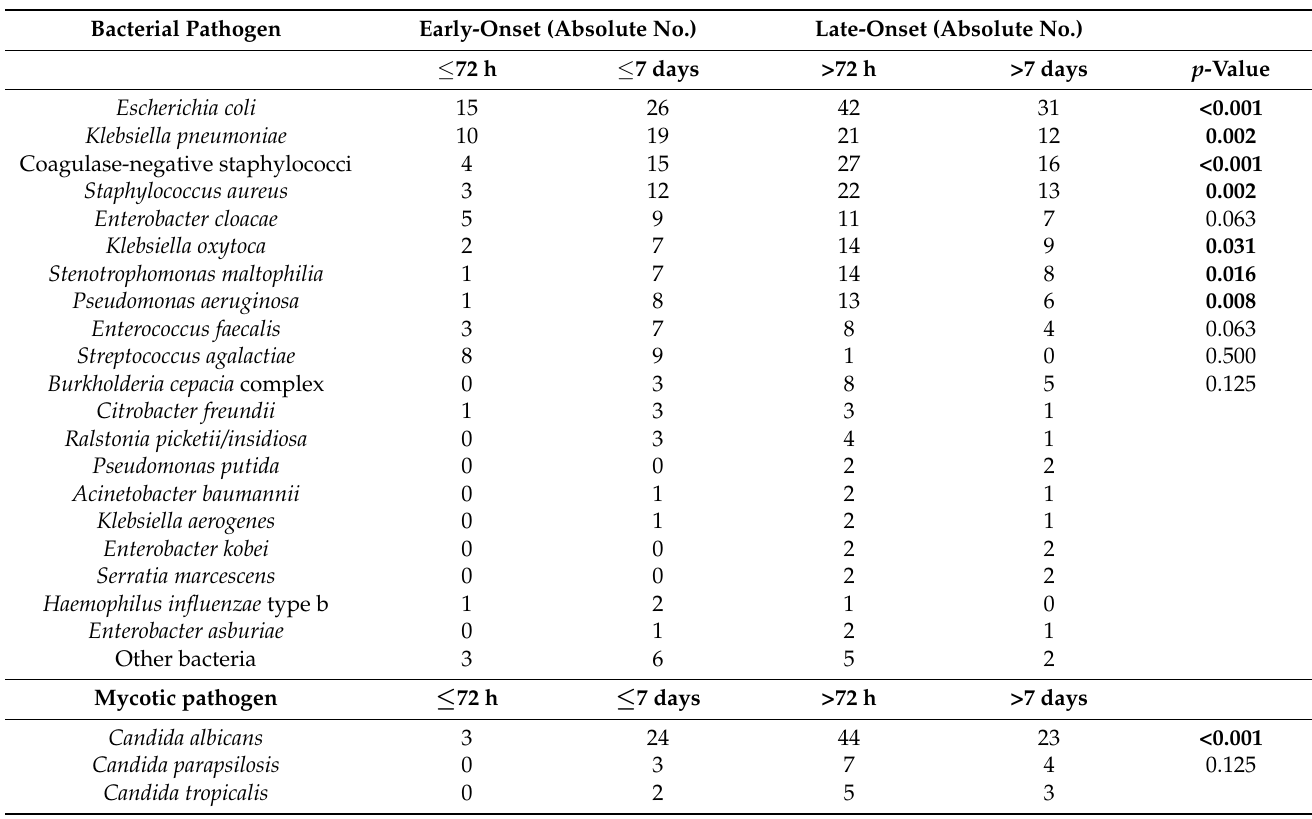
Table 2. Numbers of bacterial/mycotic pathogens from newborns treated with antibiotics with regard to different cut-offs for distinguishing between early- and late-onset infections. Bacterial Pathogen Early-Onset (Absolute